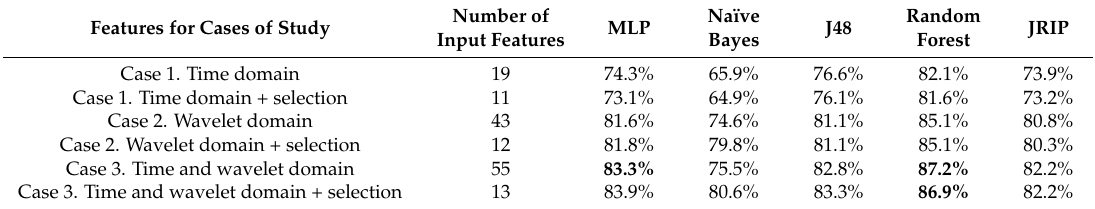
Table 7. Activity classification accuracy for MLP, Naïve Bayes, J48, Random Forest, and JRIP algorithms.